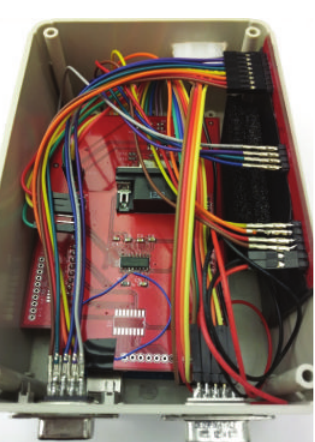
Figure 12: Local controller for level 2 charging station with